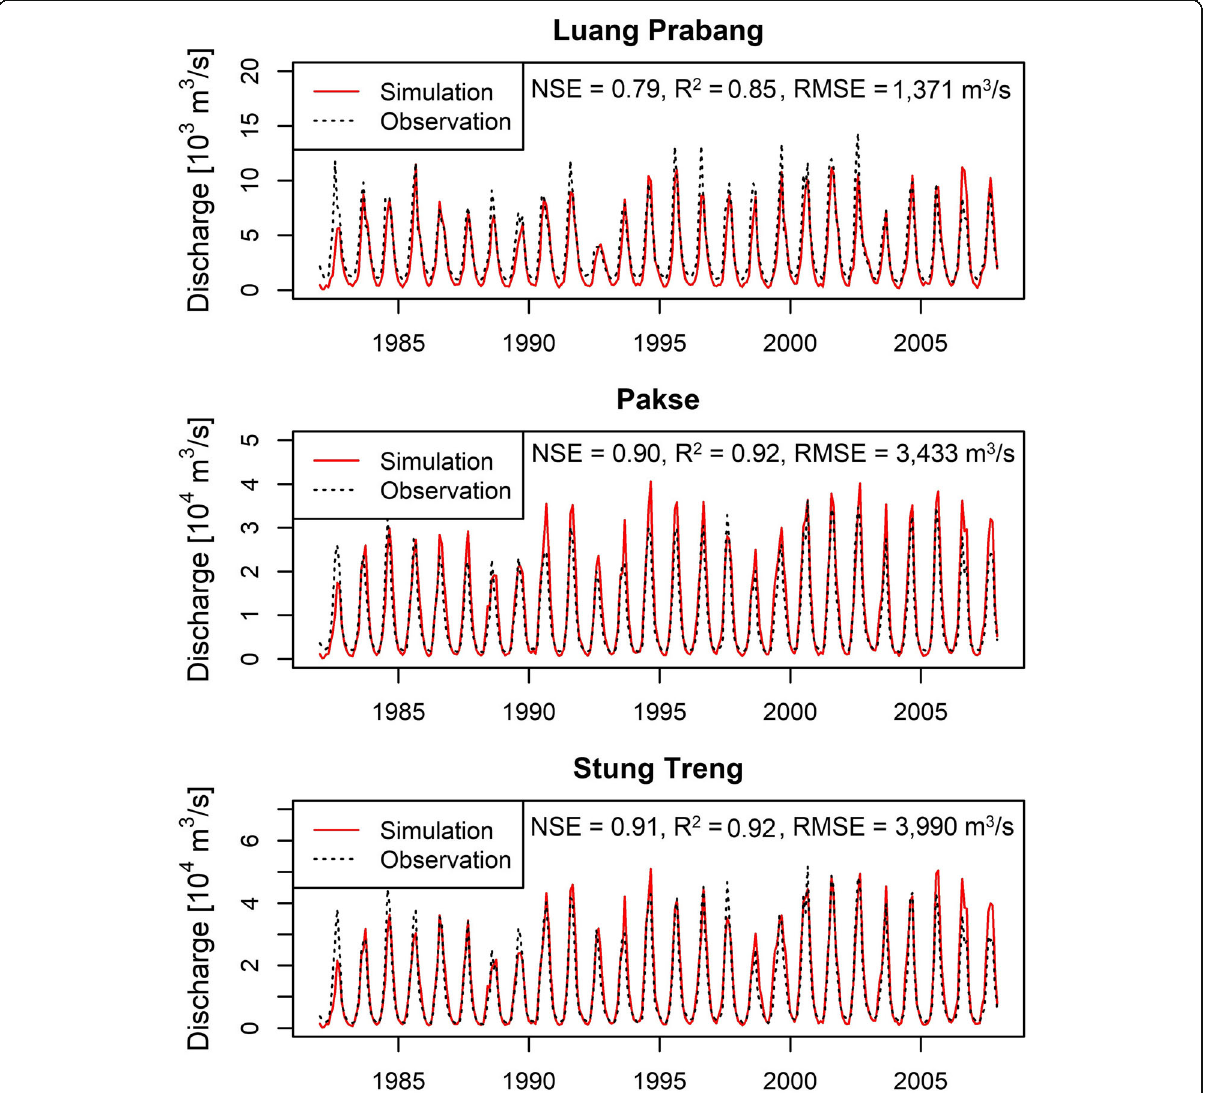
Fig. 2 Monthly simulated and observed discharges at Luang Prabang, Pakse, and Stung Treng for the period of 1982 – 2007. Model performance for river discharge was evaluated by Nash – Sutcliffe efficiency (NSE), coefficient of determination ( R 2 ), and root mean square error